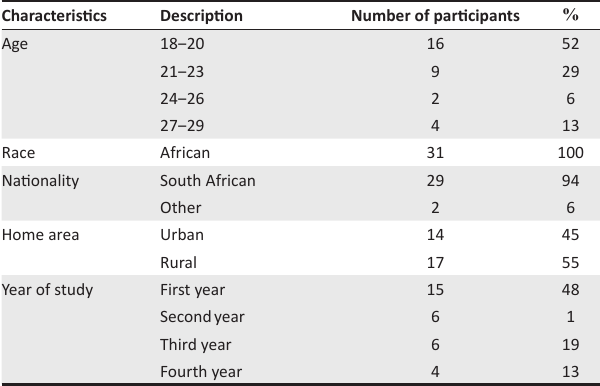
TABLE 2: Demographic information of the participants ( n =